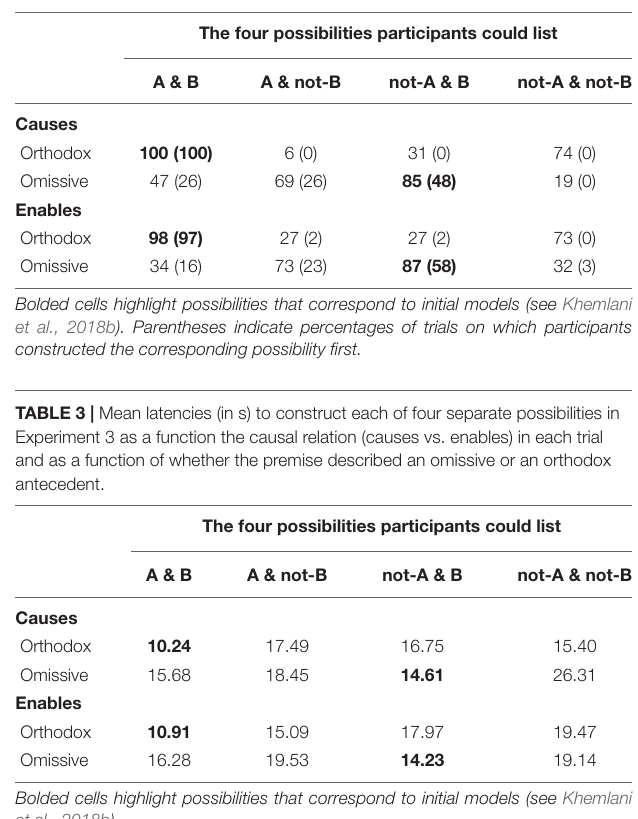
TABLE 2 | Percentages of trials on which participants in Experiment 3 listed four separate possibilities for trials that concerned omissive and orthodox causal relations.